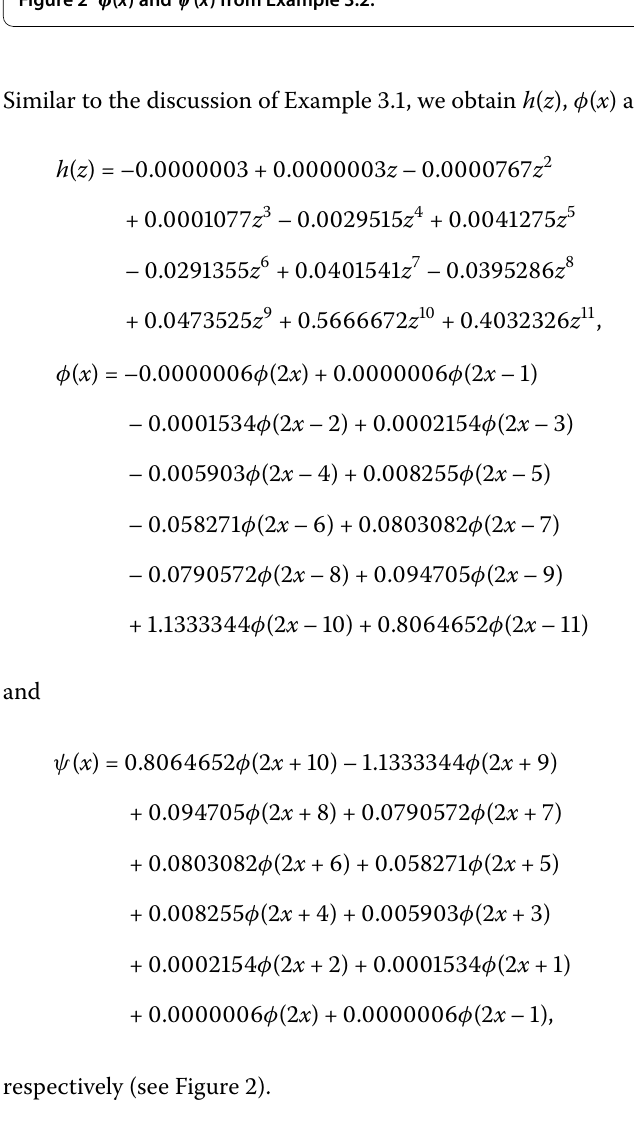
Figure 2 φ ( x ) and ψ ( x ) from Example